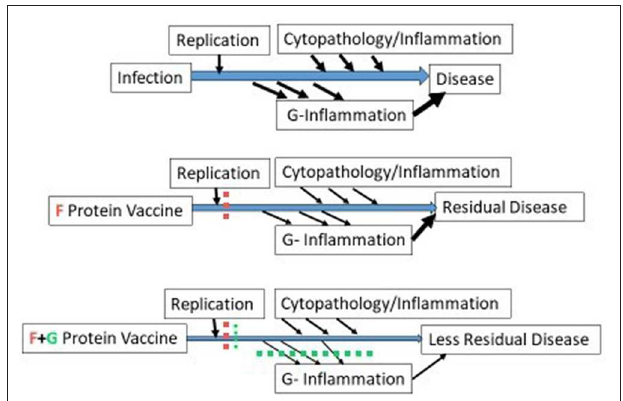
FIGURE 1 | Enhanced disease prevention with the addition of G to an F protein vaccine. The three schematics represent disease pathogenesis associated with no vaccine (1st schematic), an F protein vaccine (2nd schematic), and an F + G protein vaccine (3rd schematic). For all three, two types of disease pathogenesis are represented, one associated with virus replication and cytopathology (above the line) and the other induced by the RSV G protein (below the line). In mice, G induced disease includes increased inflammatory cells and mucus in the lungs and increased signs of obstructive airway disease and is not dependent on level of virus replication ( 95–97). In the second schematic, an F protein vaccine prevents much but not all virus replication and much of the disease pathogenesis represented above the line. In the third schematic, addition of G to an F protein also prevents disease pathogenesis represented below the line. The width of the arrows indicate level of virus replication, cytopathology/inflammation, G-inflammation, or residual